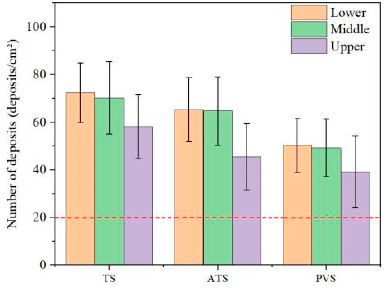
Figure 17. Number of droplet deposits.